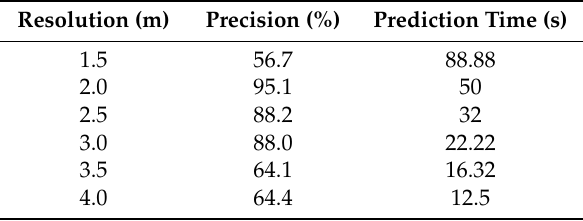
Table 5. Precision values and prediction time for different resolutions when recall fixing to 83%.